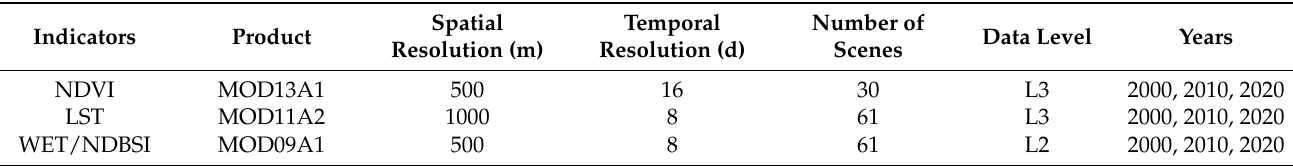
Table 1. Indicators and data description.